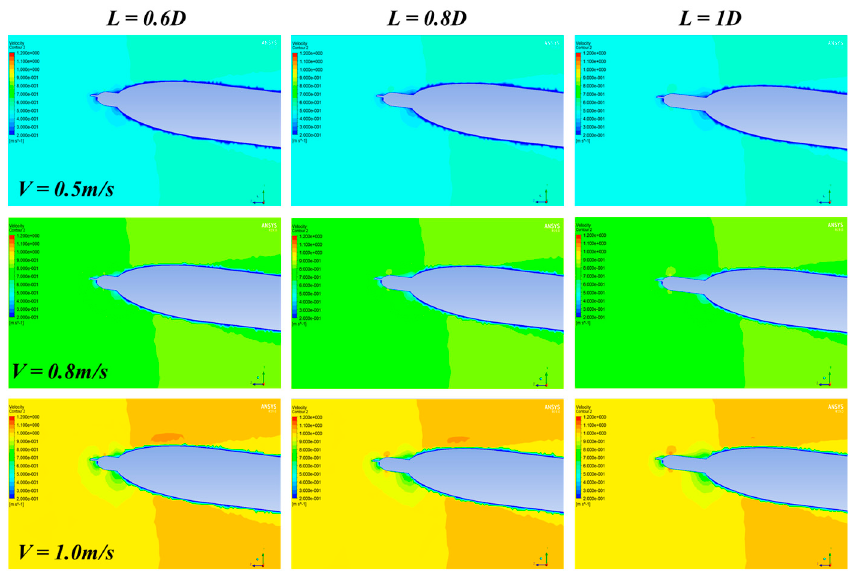
Figure 6. Velocity vectors of the turbulence AUV under various models with 6° AOA.